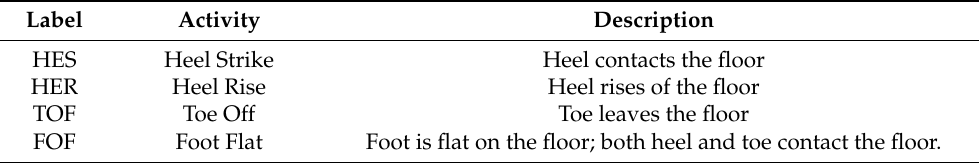
Table 4. Characteristic events of gait analysis: annotation of Smart-Insole dataset, Level 2.